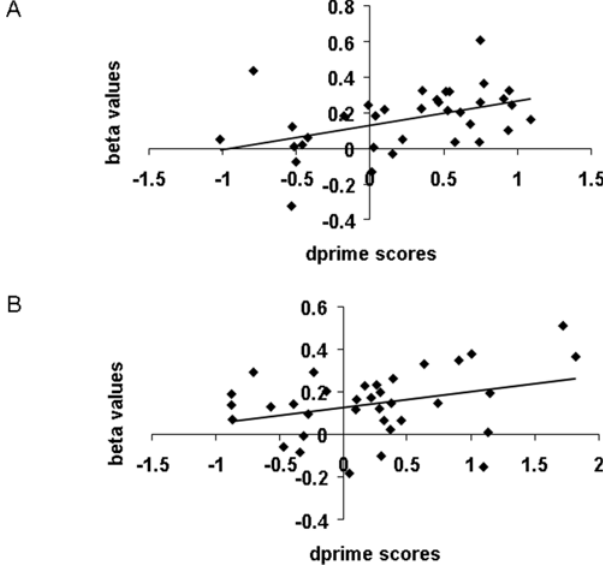
Figure 5. Better performance on the VSTM task for angry versus happy faces (A), and for angry versus neutral faces (B), was correlated with greater activity in the GPi. doi:10.1371/journal.pone.0003536.g005 PLoS ONE |